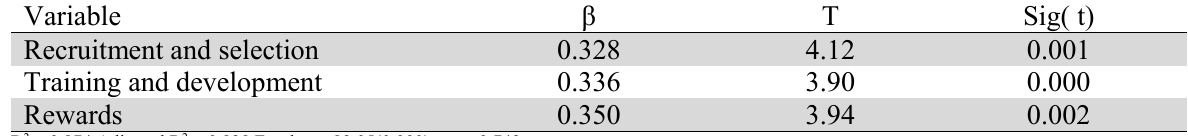
Multiple linear regression analysis to test the relationship between Green HRM practices and environmental